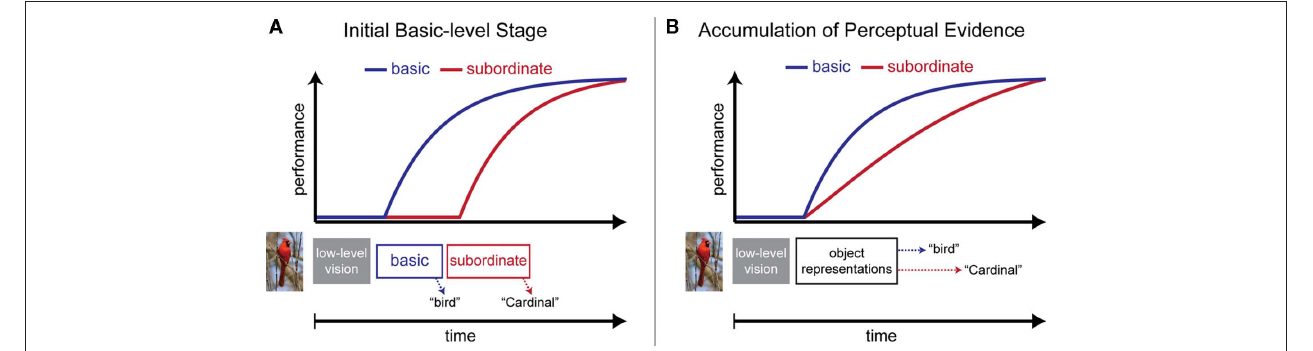
Figure 1 | illustration of two competing accounts of the basic-level advantage in object categorization. Top panels illustrate the time course for basic-level (blue) and subordinate-level (red) categorization as a function of processing time. Bottom panels illustrate proposed categorization mechanisms over time. (A) Initial Basic-level Stage . After low-level visual processing, an initial stage of processing determines an object’s basic-level category. After this initial basic-level stage has completed, a subsequent stage determines the subordinate-level category. The basic-level advantage is